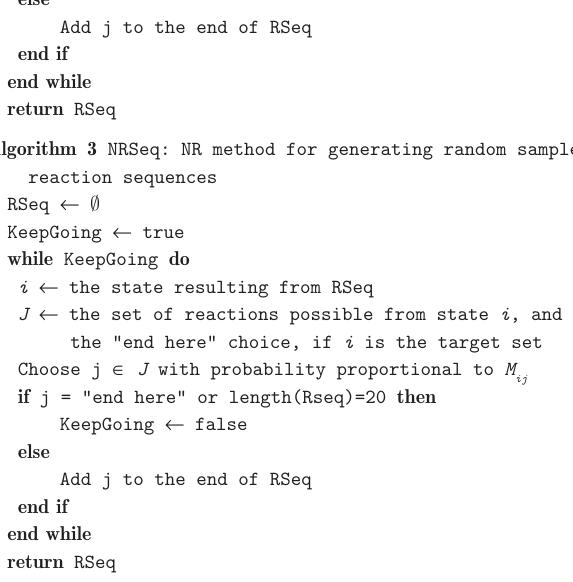
Algorithm 2 SRSeq: SR method for generating random sample reaction sequences